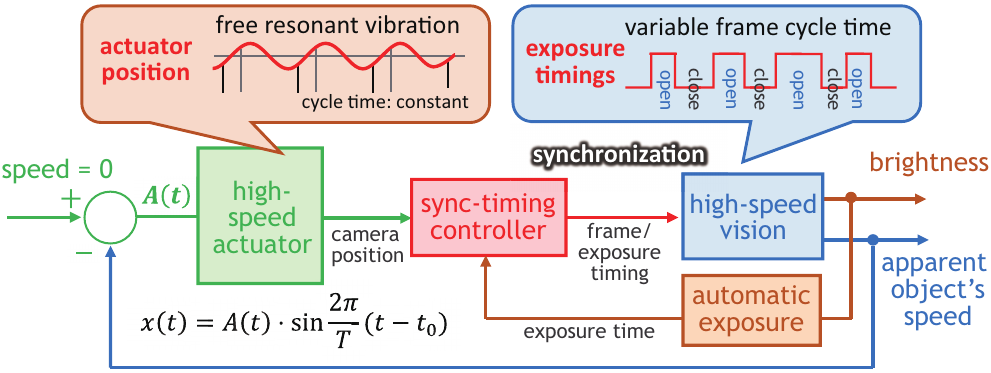
Figure 3. Control scheme in actuator-driven frame-by-frame intermittent